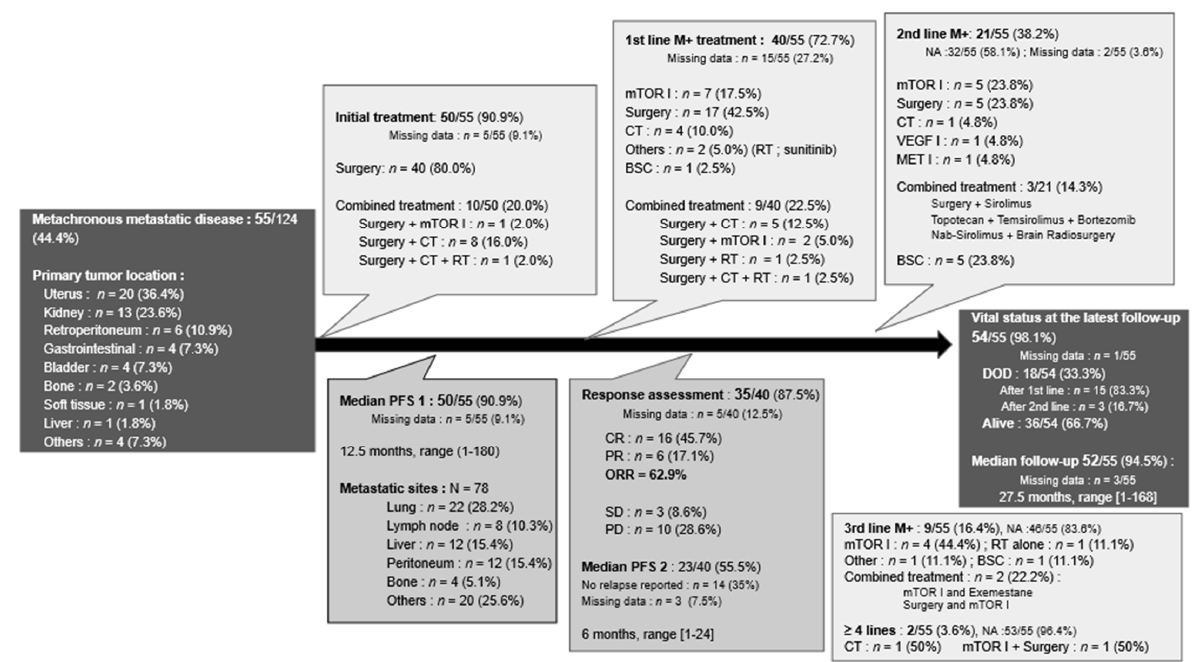
Figure 4. Flowchart of the management for metachronous metastatic PEComas. Abbreviations: BSC: best supportive care; CR: complete response as defined by RECIST 1.1 criteria; CT: chemotherapy; DOD: dead of the disease; I: inhibitors; M+: